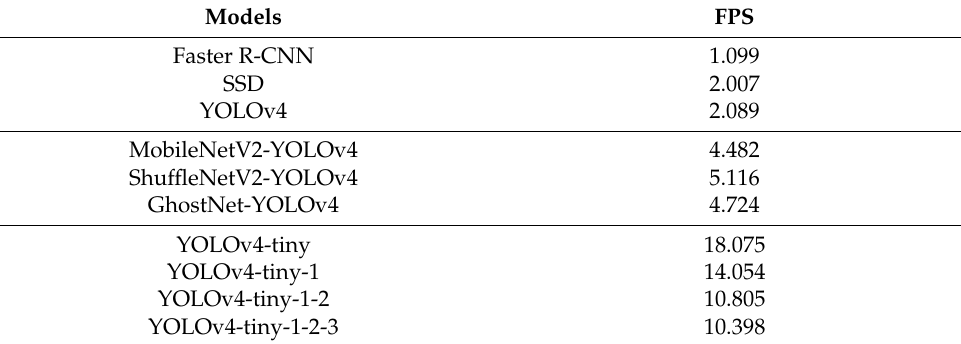
Table 5. Comparison of the model detection speed on the edge computing